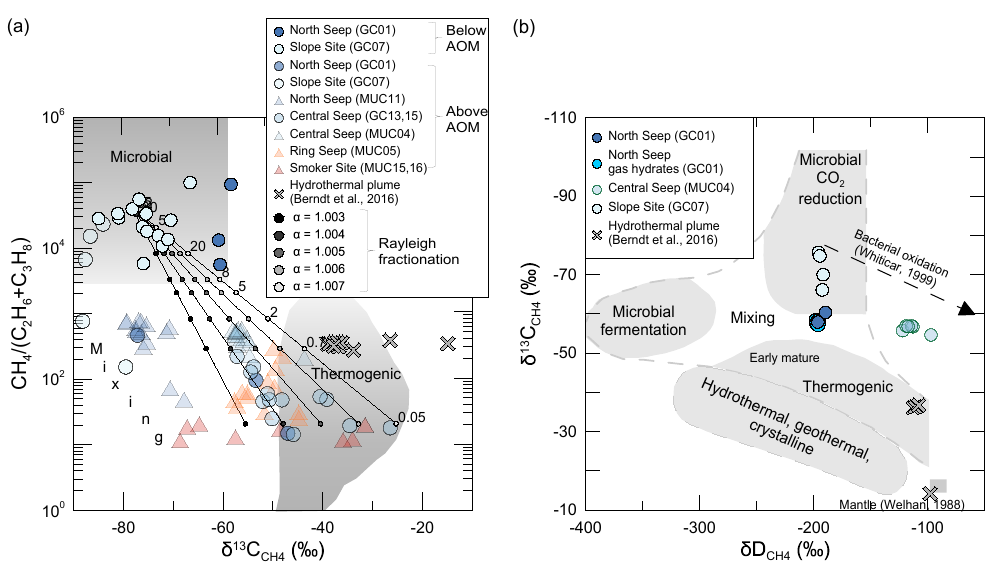
Figure 8. Hydrocarbon, δ 13 C CH , and δ D isotope data for Guaymas Basin seep sites and Smoker and Slope sites. Hydrothermal plume data 4 are shown for comparison. Note that hydrocarbon and δ 13 C CH data are from Berndt et al. (2016). (a) CH 4 / (C 2 H 6 + C 3 H 8 ) ratios versus 4 δ 13 C CH data are shown after a modified Bernard diagram (Schmidt et al., 2005). Pale symbols indicate samples above the AOM zone. 4 Rayleigh fractionation lines show the effect of (microbial) methane oxidation, and labels indicate the residual methane in %. (b) Carbon ) and hydrogen ( δ D CH ) isotope data after Whiticar (1999) and (Welhan, 1988). Pale symbols (Central Seep – MUC04) indicate ( δ 13 C CH 4 4 samples above AOM